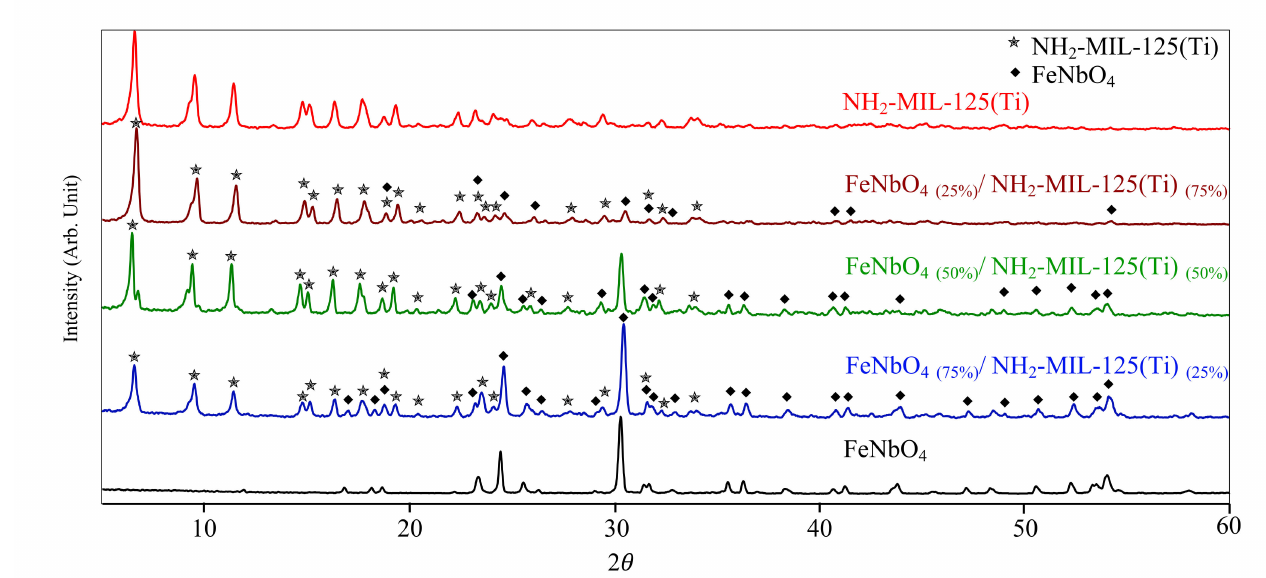
Figure 1. PXRD patterns of FeNbO 4 , NH 2 -MIL-125(Ti), and FeNbO 4 /NH 2 -MIL-125(Ti) composites. Table 1. Physical properties of NH 2 -MIL-125(Ti), FeNbO 4 and their composites.